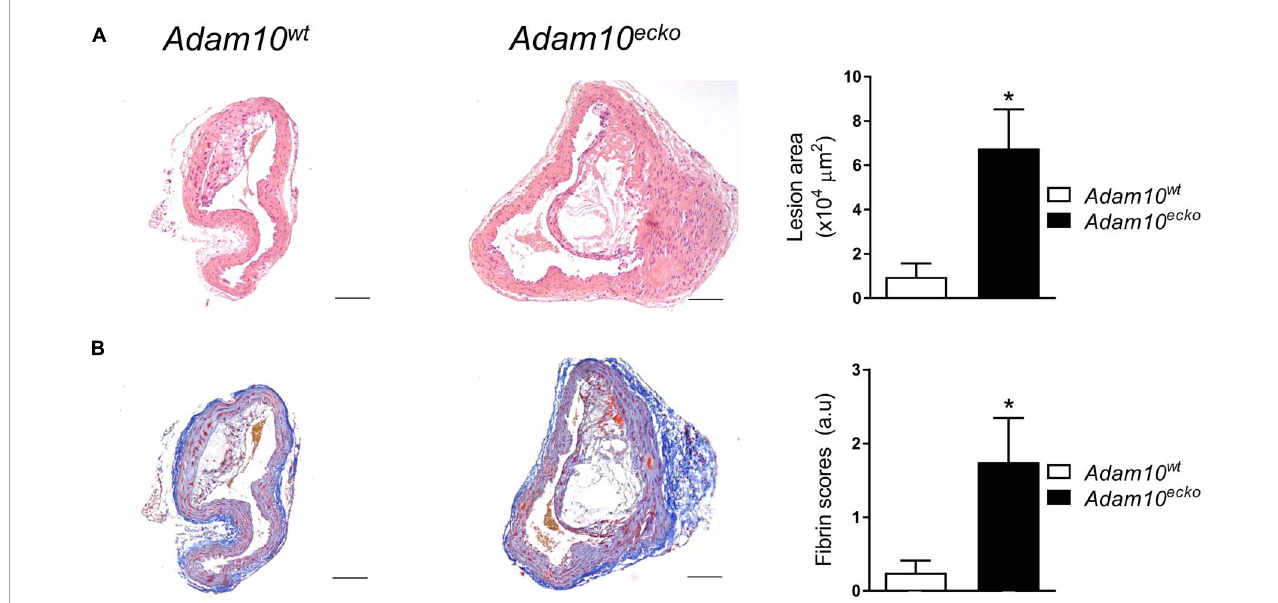
FIGURE2 Atherosclerotic lesion size and intraplaque fibrin deposits are increased in Adam10 ecko mice. (A) Examples of HE-stained plaques in brachiocephalic trunk and quantification of atherosclerotic lesion area ( n = 5–7). (B) Examples of MSB-stained plaques in brachiocephalic trunk and pathological scoring ( n = 8) of intraplaque fibrin deposits as evidence for IPH. * p ≤ 0.05.